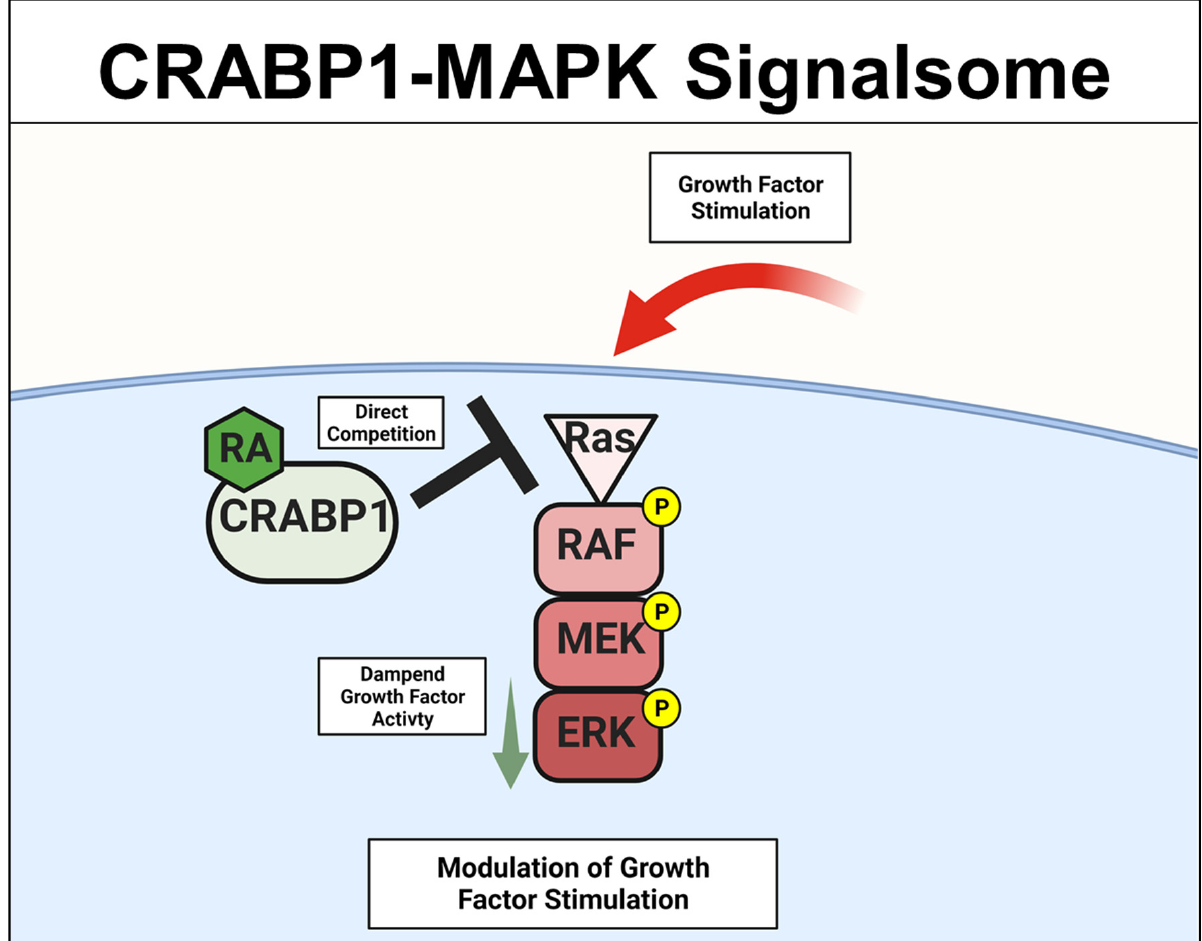
Figure 2. CRABP1-MAPK signalsome. The action of CRABP1-signalsome in growth-factor stimulated MAPK activity is mediated by its direct competition with Ras, resulting in dampened MAPK activation. CRABP1: Cellular Retinoic Acid Binding Protein 1, RA: retinoic acid, RAF: rapidly Accelerated Fibrosarcoma, MEK: mitogen-activated protein kinase kinase, ERK: extracellular-signal-regulated kinase.